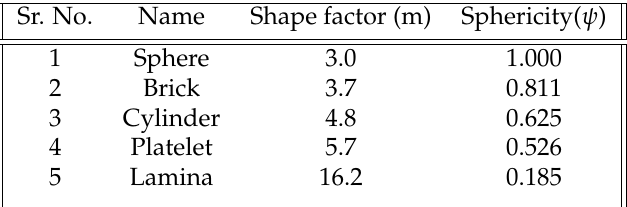
Table 1. The values of different shapes of nanoparticles [41,42] Sr.